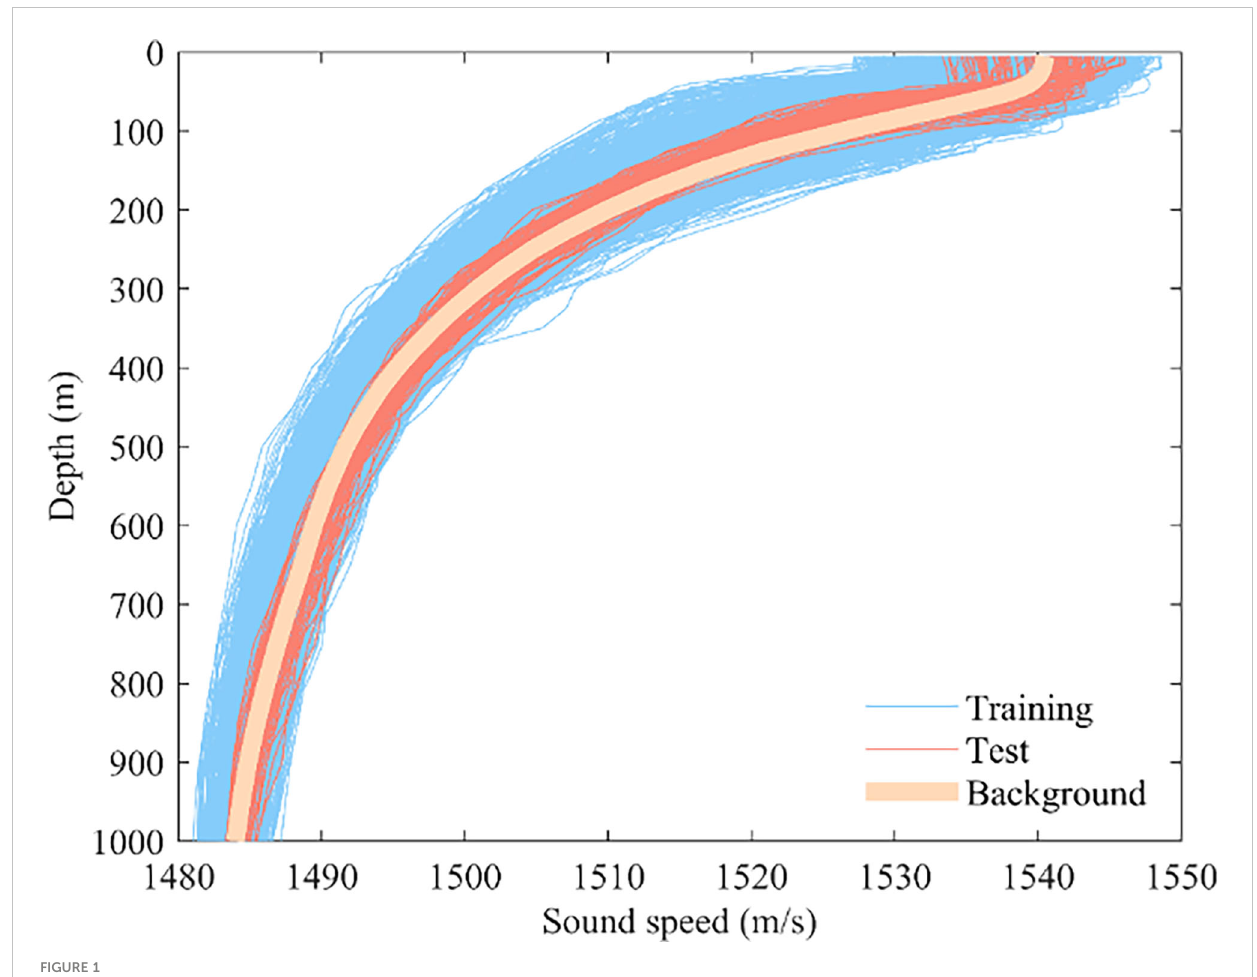
FIGURE 1 Sound speed pro fi le samples and background pro fi